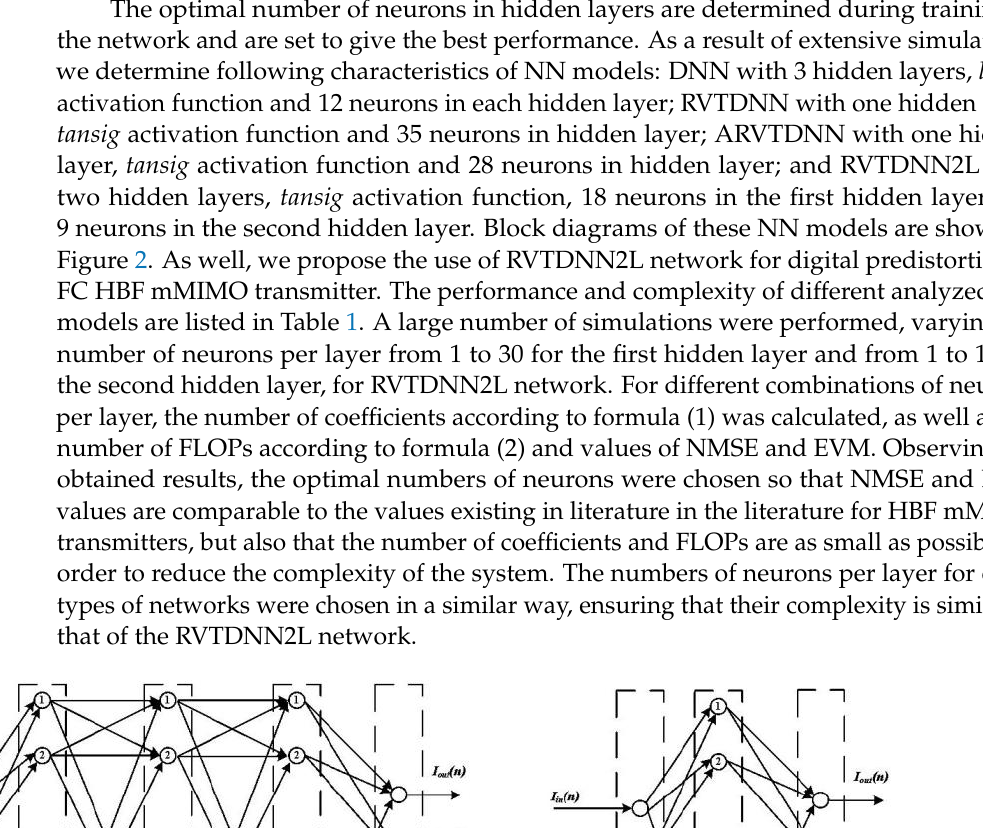
Figure 2. Block diagrams of the proposed NN models: ( a ) DNN, ( b ) RVTDNN, ( c ) ARVTDNN, ( d ) RVTDNN2L. 3. Results In this section, some DPD simulation results of the SU FC HBF mMIMO transmitter are presented. Individual PA units in transmitter are modeled using NN, based on meas- urement data from an actual PA. A two-stage PA (CFH 2162-P3 PA) with a 14 dB gain, and P1dB of 37 dBm driven in a hard compression region was used. The modulated wave- form with channel bandwidth of 20 MHz, was fed into this power amplifier model at 2140 MHz. The process of PA modeling is shown in Algorithm 1 in Appendix A. Single PA has been modeled using one RVTDNN2L with two hidden layers, tansig activation function, 32 neurons in the first hidden layer and 15 neurons in the second hidden layer. To consider nonlinear crosstalk that occurs before PA, the output of each PA is modeled as: 𝑦 𝑖 = 𝑓 𝑖 (𝑥 𝑖 + ∑ 𝛼 𝑖,𝑛 ∙ 𝑥 𝑛𝑁𝑡 𝑛=1 𝑛≠𝑖 ) (5) where 𝑥 𝑖 is the input to i -th PA, 𝑓 𝑖 is the PA response function, 𝛼 𝑖,𝑛 is the crosstalk fac- tor reflecting the impact of n -th PA to i -th PA [27]. Then NN based DPD model was cre- ated, using different NN architectures, as an integral solution to jointly compensate all PAs nonlinearity, crosstalk, I/Q imbalance and dc offset imperfections, similarly to the authors work presented in [22]. Considered DPD architecture is shown in Figure 1. To obtain the feedback signal, used for the DPD learning, the outputs of the individual PAs are firstly extracted, then co-phased and combined in the analog domain before being ap- plied, meaning that direct transmit-end feedback is considered. The basic concept of hybrid beamforming is to split both the precoding and combin- ing weights to baseband digital weights and RF band analog weights. The problem of determining these weights is quite a large topic and is not considered here. In this paper, the orthogonal matching pursuit algorithm which is implemented in Matlab and